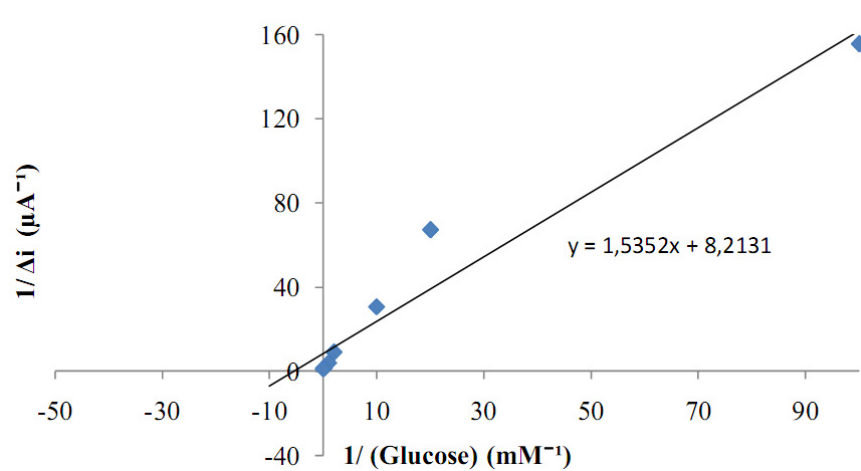
Figure 9. The effect of glucose concentration upon the amperometric response of the biosensor (Lineweaver-Burk plot, in pH 7.5 phosphate buffer and at a 0.4 V operating potential, 25